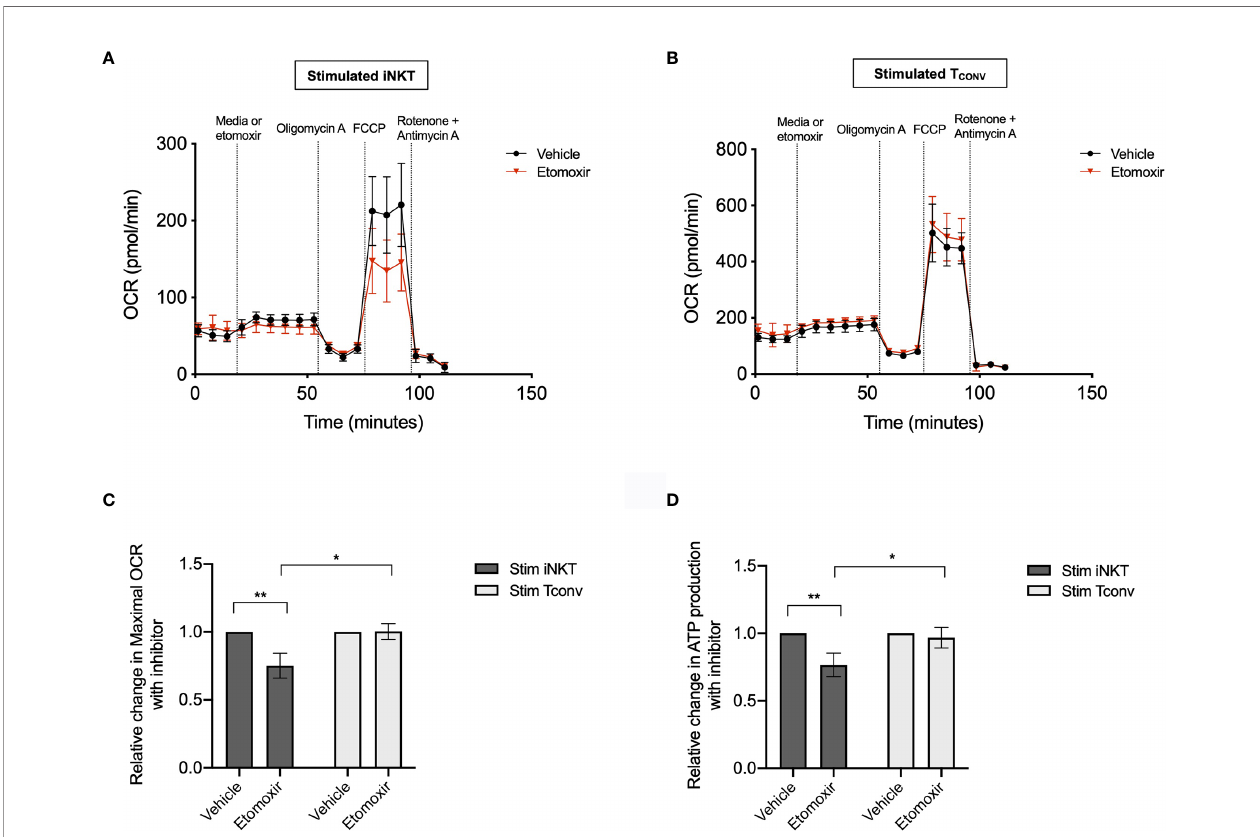
FIGURE 5 | Stimulated human iNKT cells oxidize fatty acids more than stimulated T CONV . (A, B) Real-time measurements of oxygen consumption rate (OCR) of 48-hour stimulated iNKT cells (A) and stimulated T CONV (B) from matched human donors were obtained on a Seahorse Bioanalyzer. OCR was measured after sequential additions of media (vehicle, black) or 4µM etomoxir (red) followed by 1.5µM oligomycin A, 0.5µM FCCP, and 0.5µM rotenone and antimycin (A) Graphs depict representative example of 3 independent, matched human donor replicates. Seahorse data is representative of n=3 biological replicates and n=6 technical replicates. (C) Summary data displaying percent change in maximal OCR upon FCCP (mitochondrial uncoupler) injection with pre-injection of etomoxir relative to vehicle controls for stimulated iNKT cells (dark grey) and stimulated T CONV (light grey). Graphs depict summary data from 3 independent matched human donors. Asterisks indicate statistical signi fi cance (*p < 0.05, **p < 0.01) determined by unpaired, two-way student ’ s t tests. (D) Summary data displaying the percent change in ATP production with etomoxir addition relative to vehicle controls for stimulated iNKT cells (dark grey) and stimulated T CONV (light grey). Graphs depict summary data from 3 matched human donor biological replicates of iNKT cells and T CONV ; matched sets of cells were collected, stimulated, and analyzed for Seahorse fl ux in 3 independent experiments. Asterisks indicate statistical signi fi cance (*p < 0.05, **p < 0.01) determined by unpaired, two-way student ’ s t